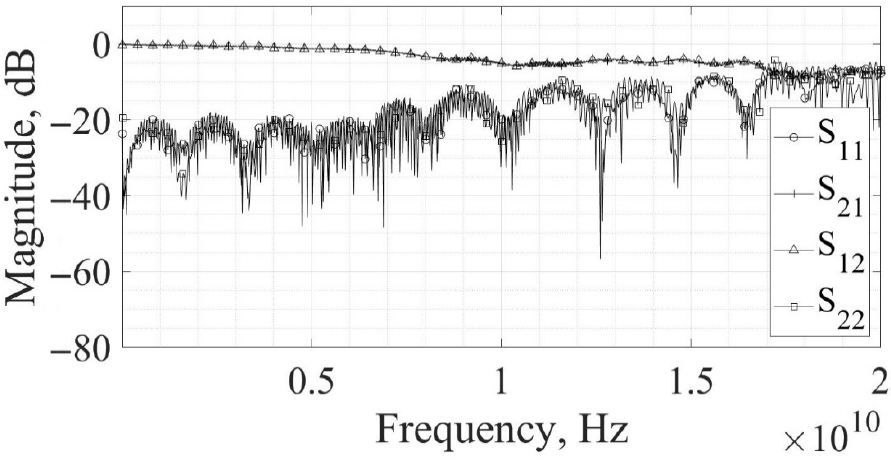
Figure 3. S parameters of MSL.